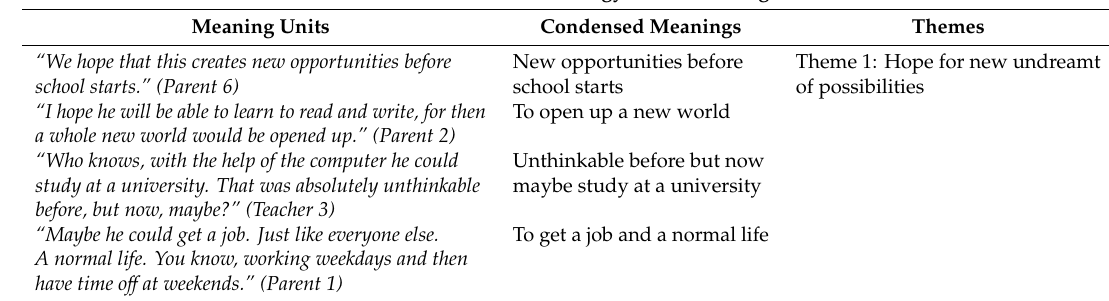
Table 3. Themes and examples of connected meaning units and condensed meaning in the second